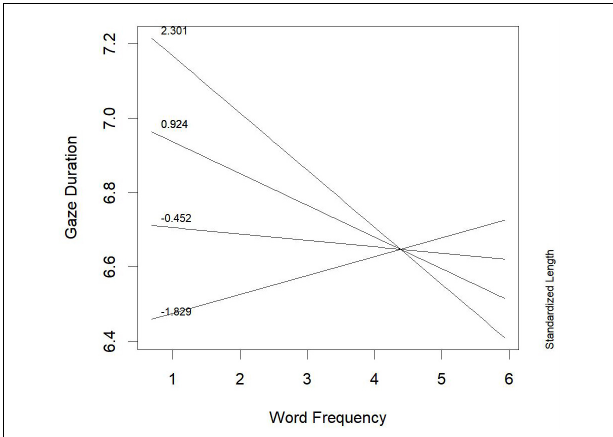
FIGURE 3 | Words derived from verb base: word frequency by word length interaction effect on gaze duration.